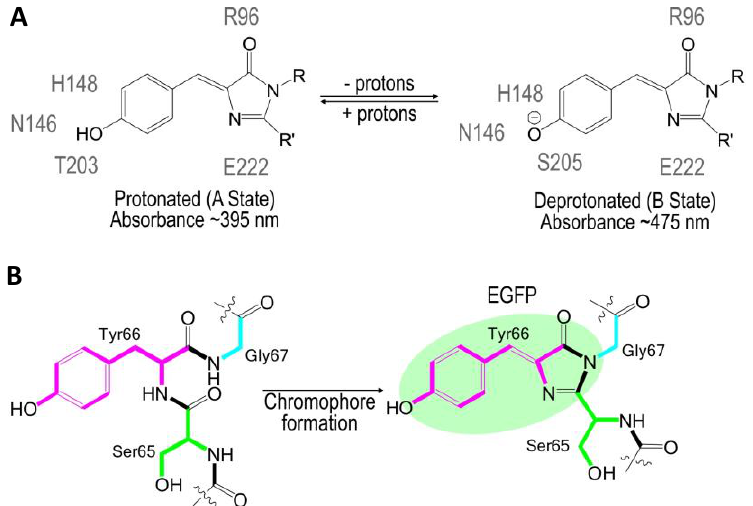
Figure 1. ( A ) A two state model of pH dependent ground states of wtGFP. Four